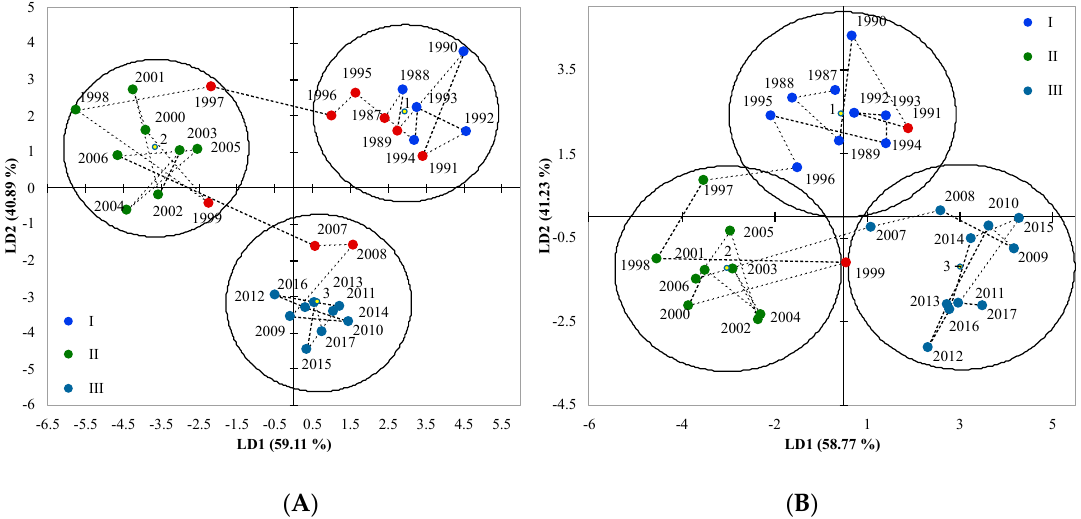
years belonging to the first, second and third ODM periods are correctly classified (Figure 5B), and the achieved overall classification accuracy is 93.5%.